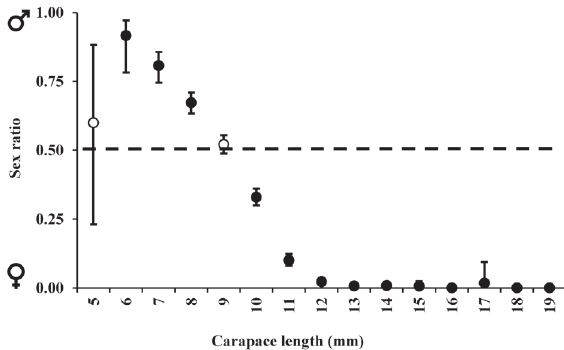
Figure 3 - Rimapenaeus constrictus . Sex ratio observed among the size classes (estimate ± standard error) for individuals sampled from January 1998 to June 2003 from the northern littoral of São Paulo state. Black circles indicate a significant deviation from a 1:1 (M:F) sex ratio (binomial test,